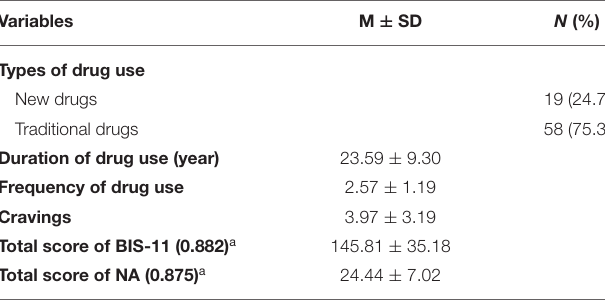
TABLE 2 | Drug use characteristics, cravings, total score of BIS-11, and NA ( N =